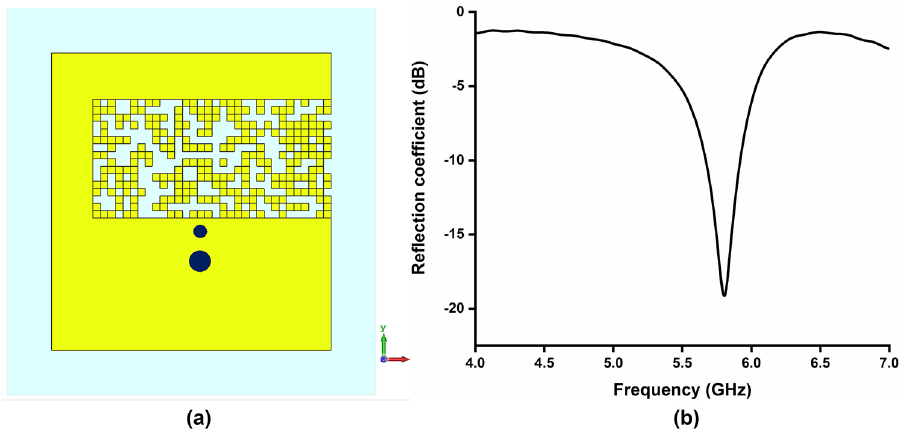
Figure 8. ( a ) Pixelated layout of Antenna C (5.8 GHz), Software used: CST Microwave Studio 2019 ( b ) reflection coefficient of Antenna C.